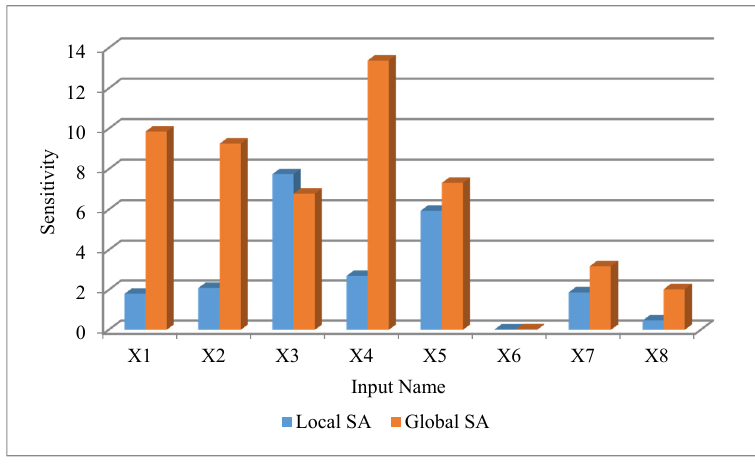
Figure 6. Comparison of local and global sensitivity for Heating Load